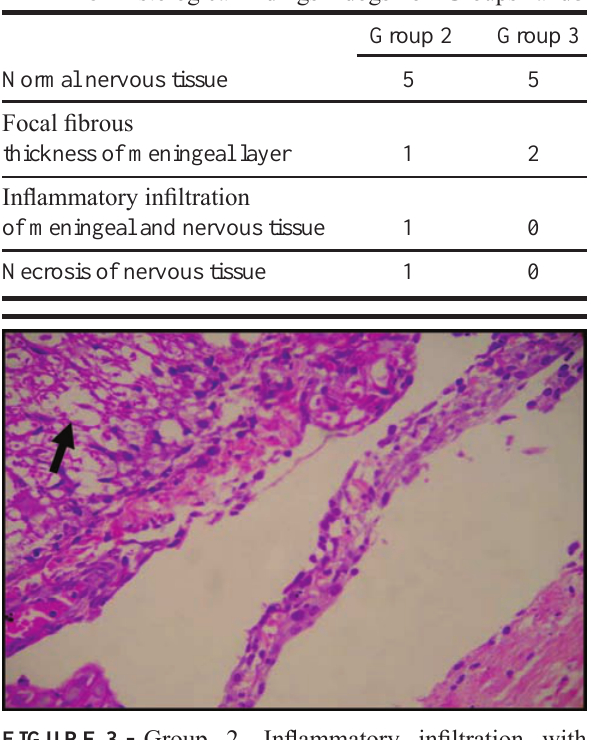
FIGURE 3 - Group 2. Inflammatory infiltration with neutrophils, lymphocytes, and mast cells inside the meningeal layer. Hemorragic focus and inflammatory reaction inside the nervous tissue with necrosis areas (arrow). H&E 40X